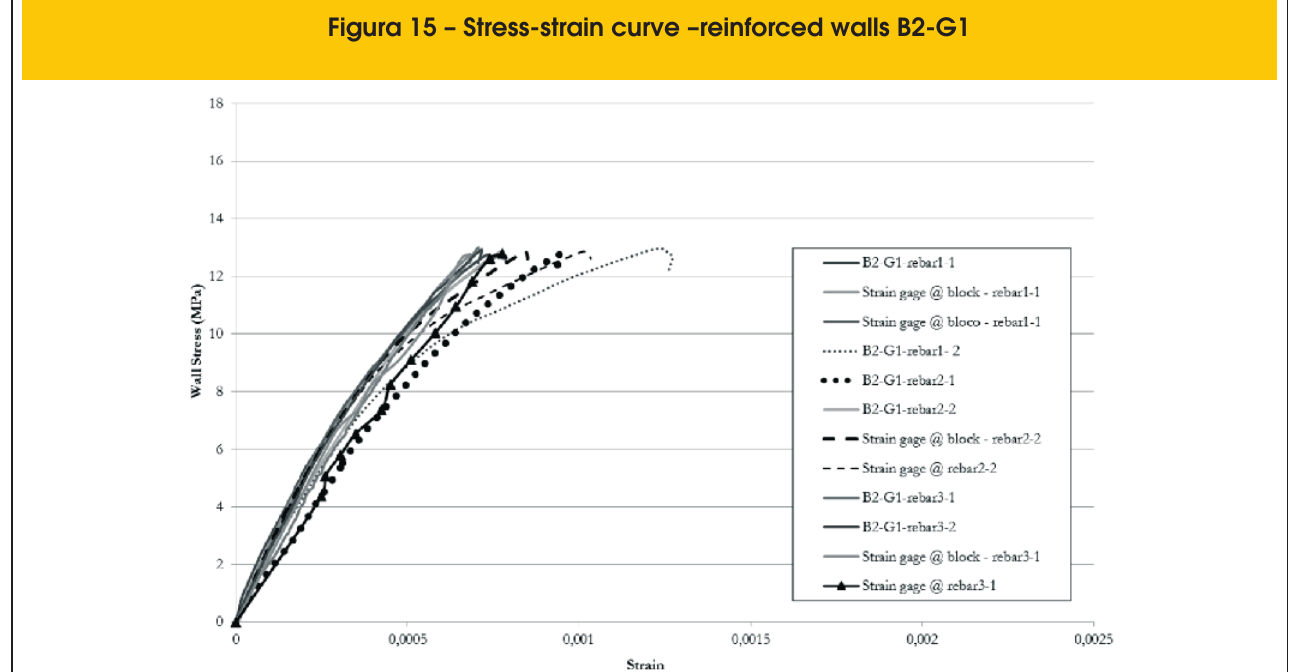
Figura 15 – Stress-strain curve –reinforced walls